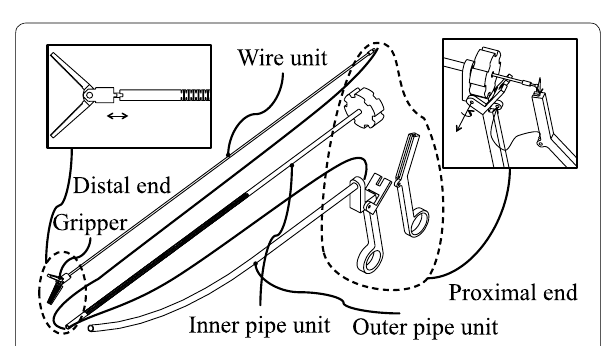
Fig. 13 The structure of an easy-to-disassemble